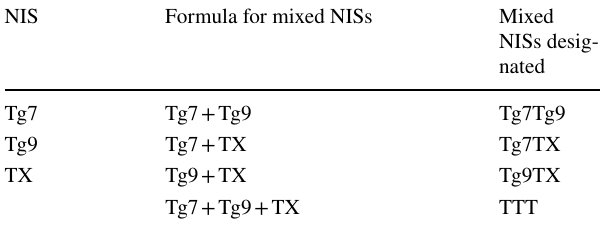
Table 1 Showing the formulation of mixed NISs at CMC values of NIS NIS Formula for mixed NISs Mixed